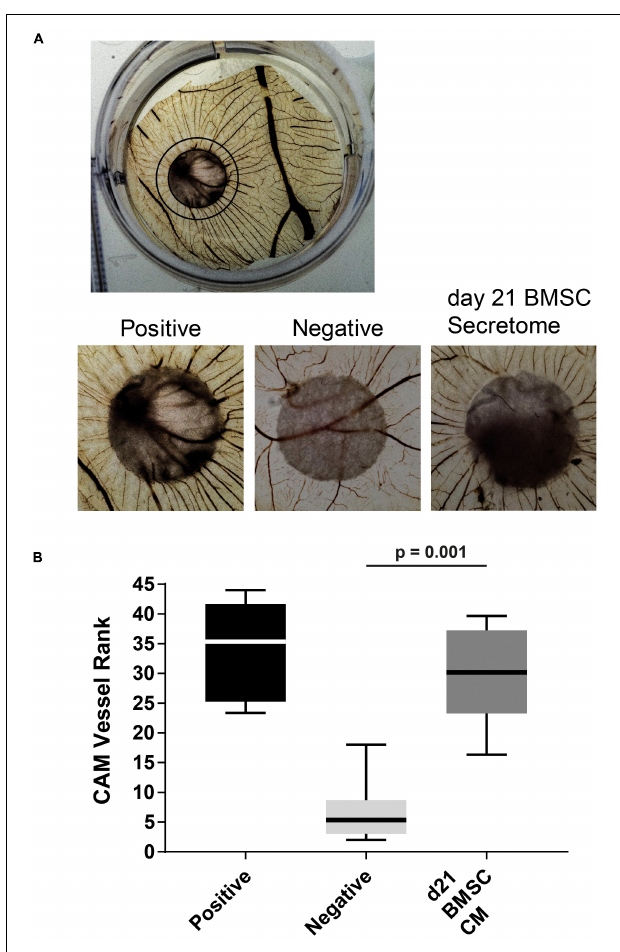
FIGURE 3 | In vivo CAM assay illustrated the pro-angiogenic potential of chondrogenically differentiated BMSC secretome. (A) Overview of treated CAM [Black circle depicts approximate range of influence of placed filter (center)]. Magnifications of chick chorioallantoic membrane incubated for 72 h with CM soaked 5 mm filter disks. Filter circles were placed on a vessel free area on day 7 of the chick development. (B) Boxplot depicting the ranking of the angiogenic potential (lowest = 1 highest = 45: average of 3 independent observers; box = interquartile range, whiskers + 1–99%). N = 6 per